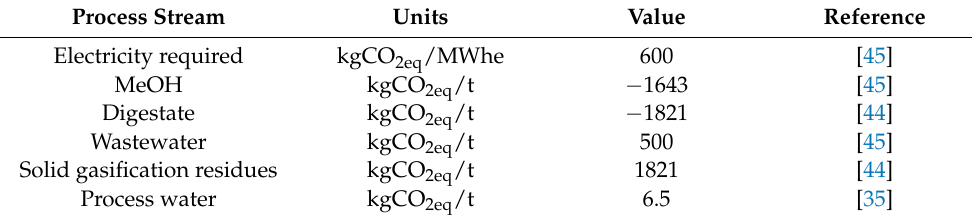
Table 2. Equivalent carbon dioxide emission of the main process streams.